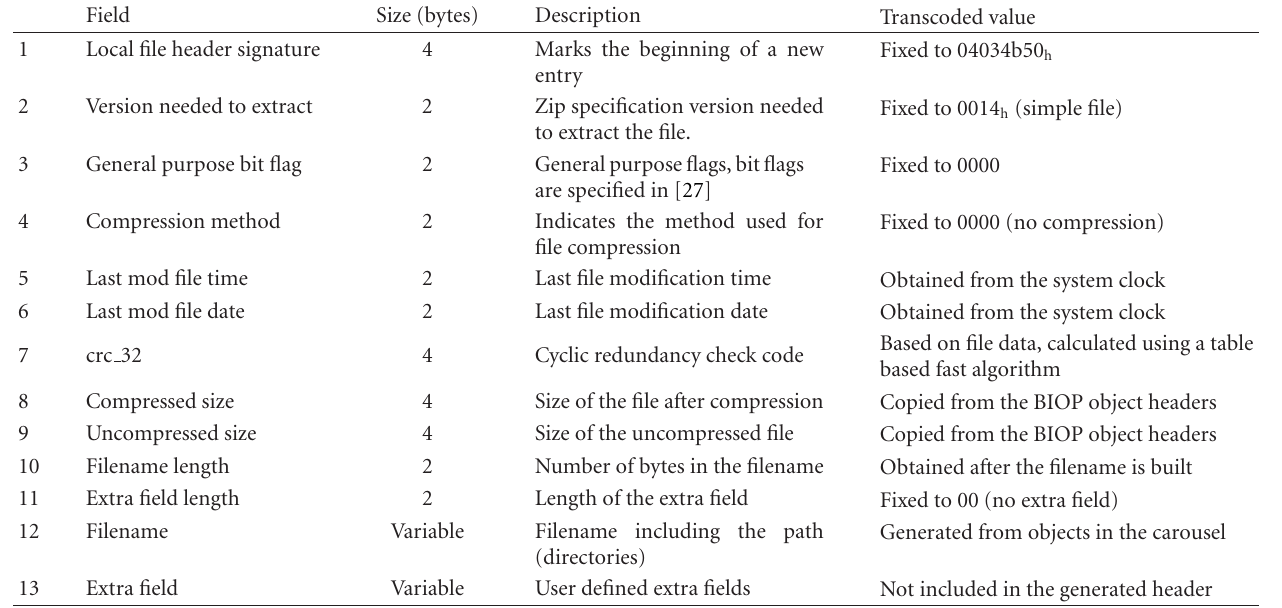
Table 3: Fields in the jar